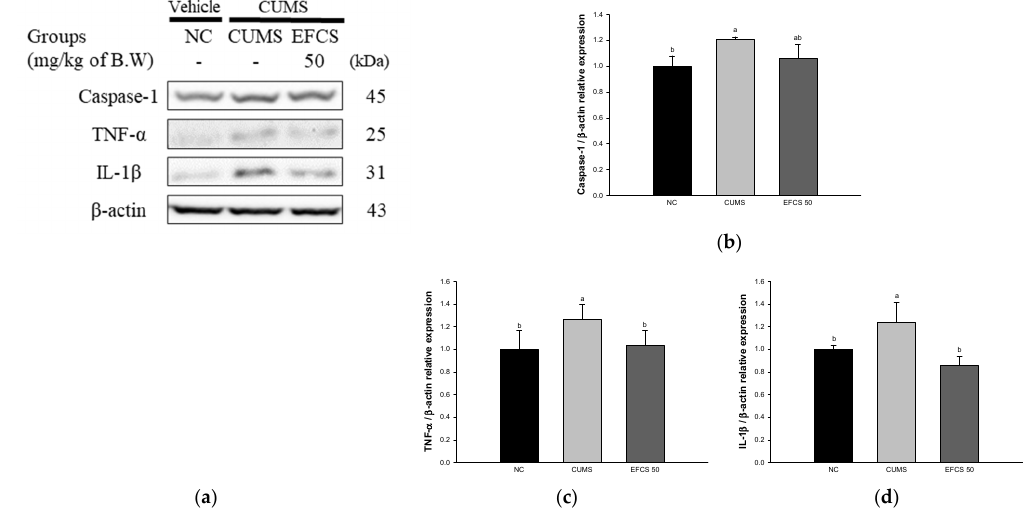
Figure 8. Effect of ethyl acetate fraction from Cedrela sinensis (EFCS) on CUMS-induced inflammation pathway in brain tissue. Western blot images ( a ), protein expression levels of caspase-1 ( b ), TNF- α ( c ), and IL-1 β ( d ) in brain tissues. Results shown are mean ± SD ( n = 3). Data are statistically considered at p < 0.05, and different lowercase letters indicate statistical significance. Means with the same letter are not significantly different.